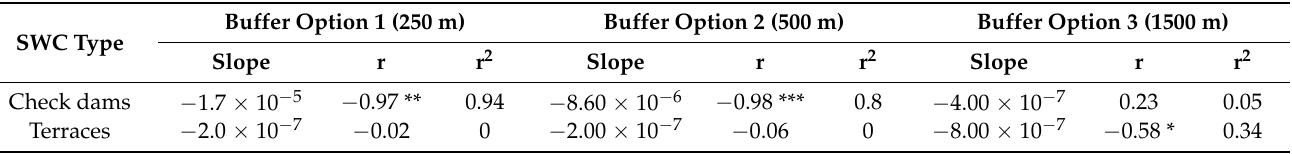
Table 2. Regional OLS regression results for the proportion of significant positive trends in the period 2011-2018.